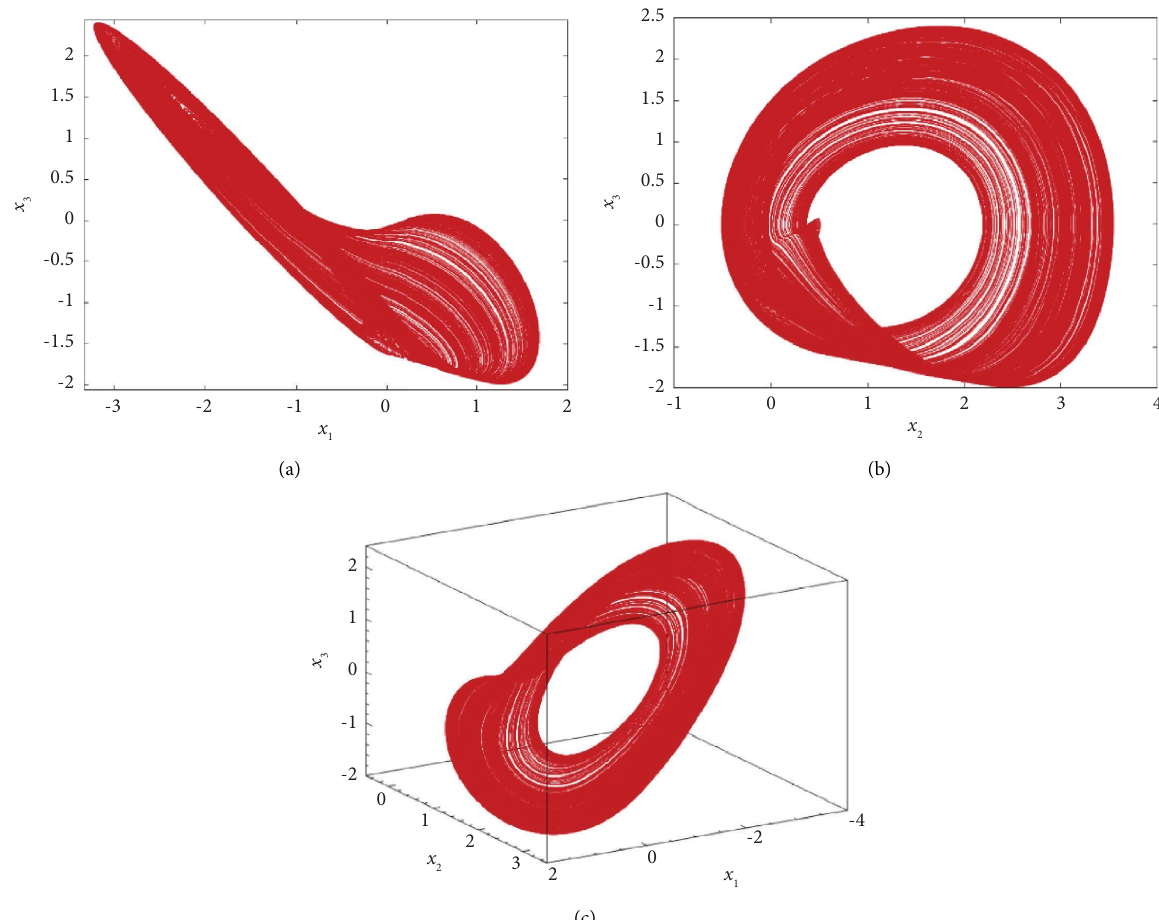
Figure 4: System phase diagram. (a) x